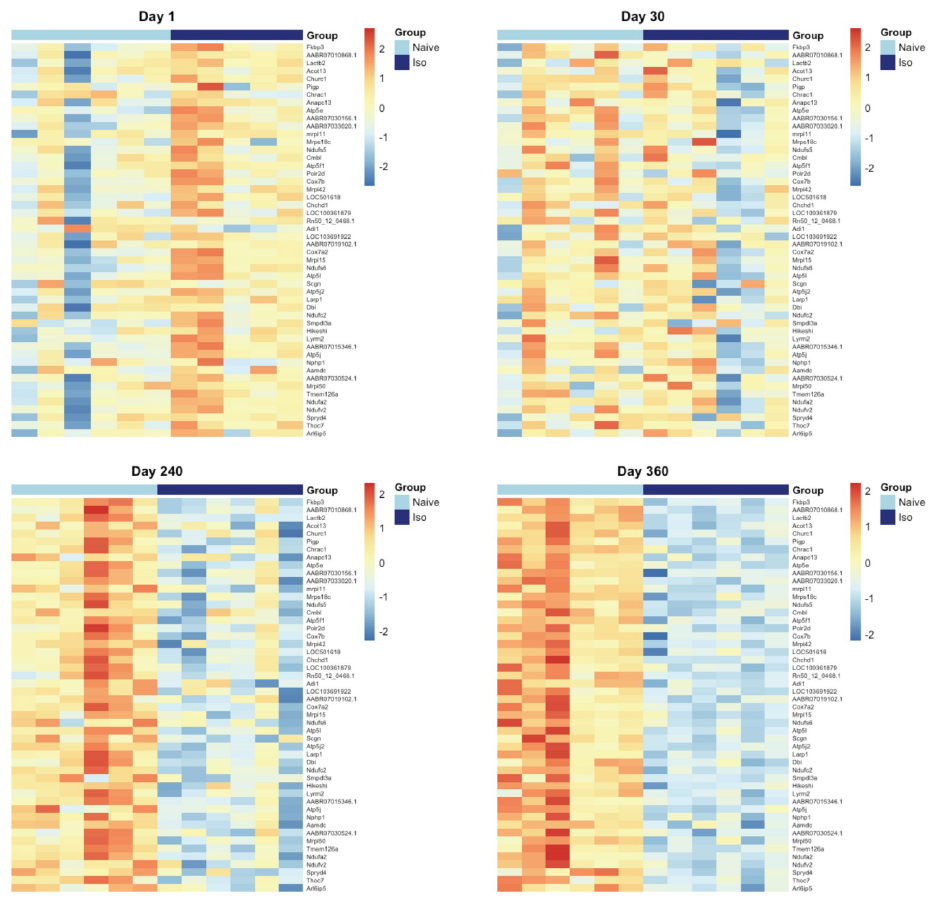
Fig 14. Heatmaps of the top 50 consistently down-regulated DEG that were identified at the later timepoints. Heatmaps were generated for top 50 consistently down-regulated DEG according to FDR at Day 360. Normalized expression levels were used and standardized within each gene. For the group scale, light blue represents na ï ve group samples and dark blue represents ISO group samples. Groups of rats exposed to air (na ï ve, n = 6/each timepoint group) or ISO (n = 5/Day 1 group, and n = 6/Day 30, 240, and 360 groups) were